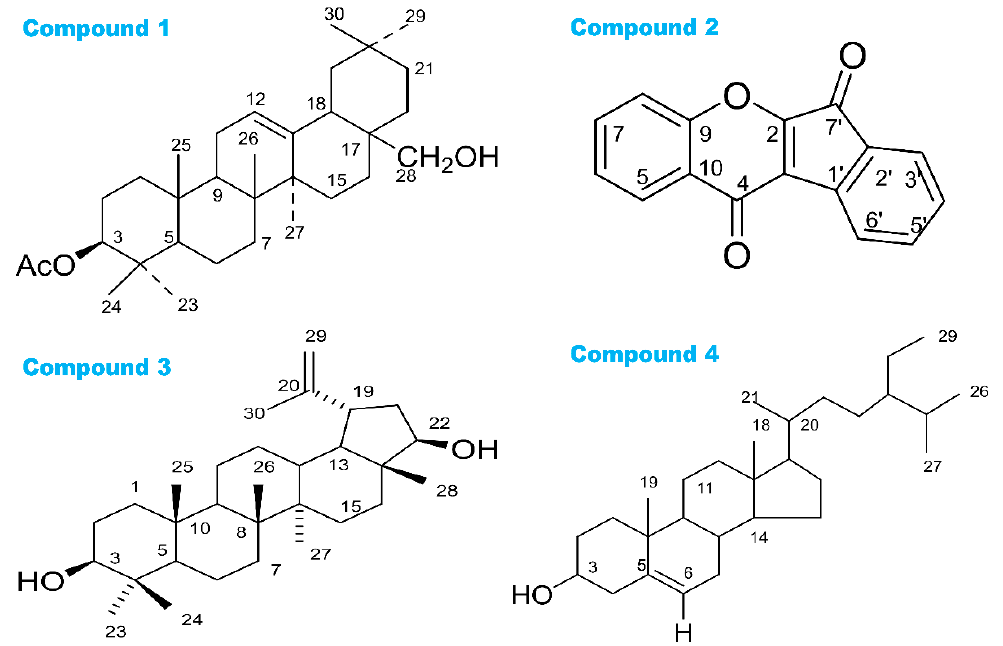
Figure 1. The structures of isolated four compounds (compound 1 : 3 β -Acetyloxy-olean-12-en-28-ol; compound 2 : Wrightiadione; compound 3 : 22 β -hydroxylupeol; and compound 4 : β -sitosterol) from W. coccinea .